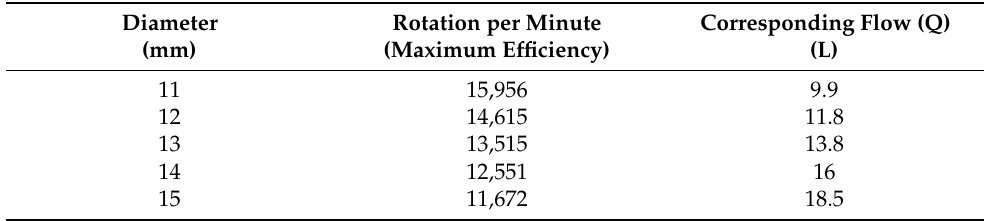
Table 1. The optimal operating parameters for different pump diameters at a pressure difference of 100 mmHg.